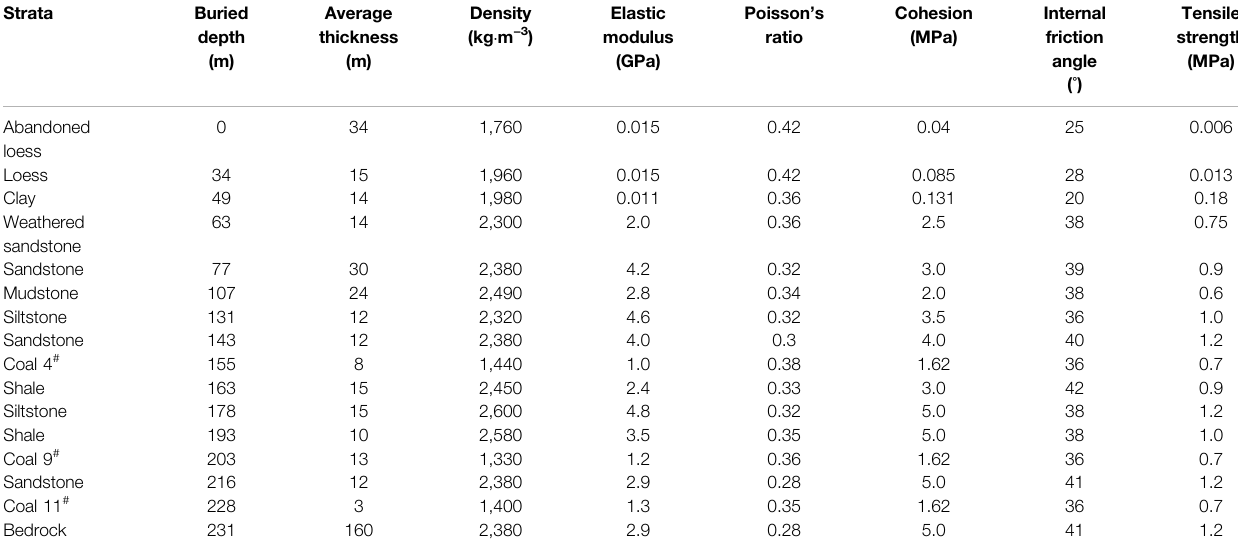
TABLE 7 | Buried depth, physical and mechanical parameters of coal seams, and strata in the Antaibao open-pit mine.